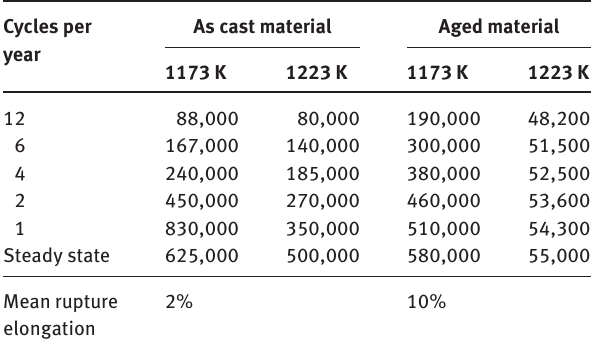
Table 10: Predicted time (hours) to produce a 1% chance of tube